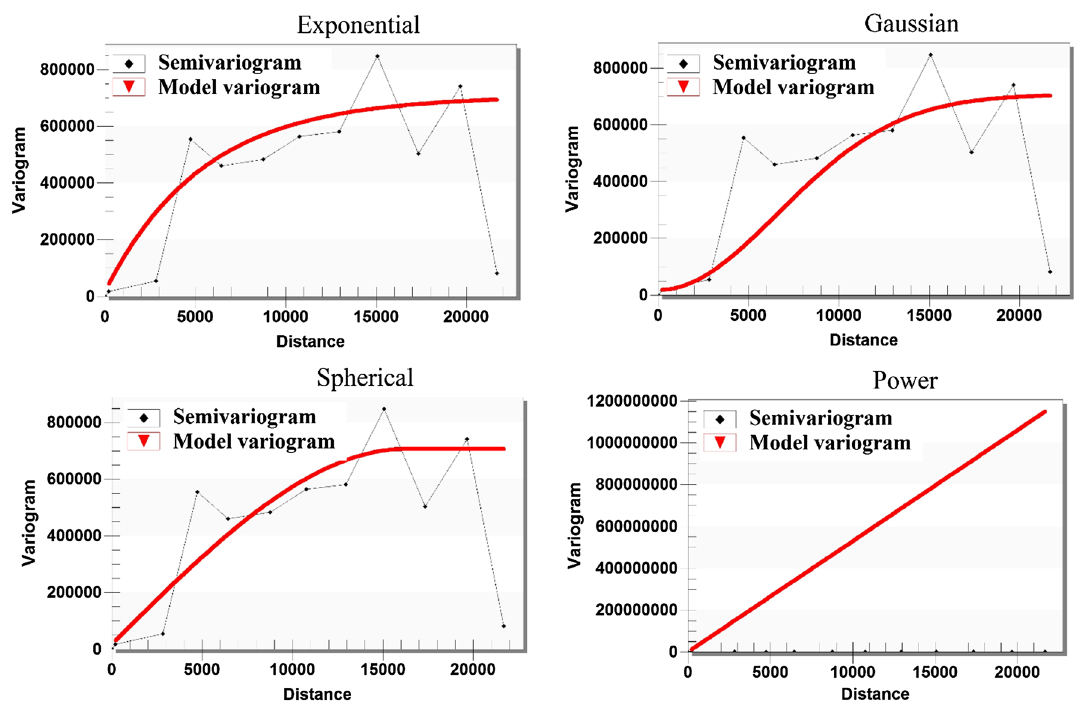
Fig. 5 Optimal variogram versus experimental case